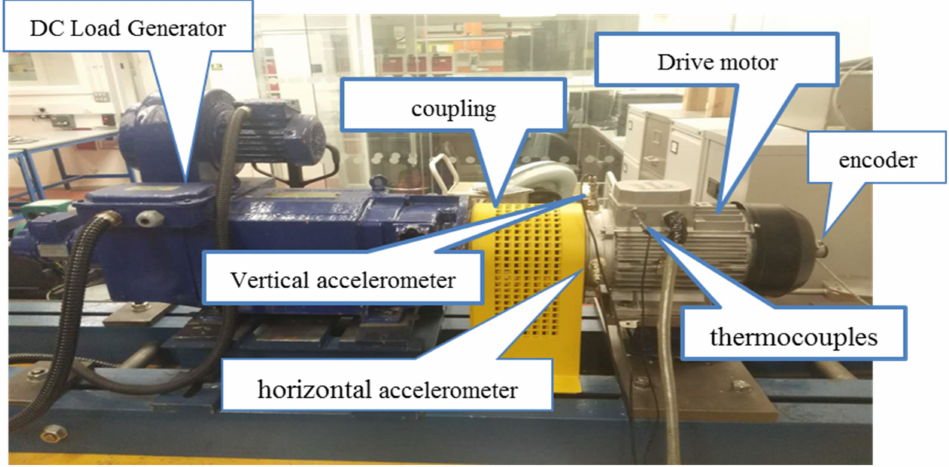
Figure 8. Experimental setup.